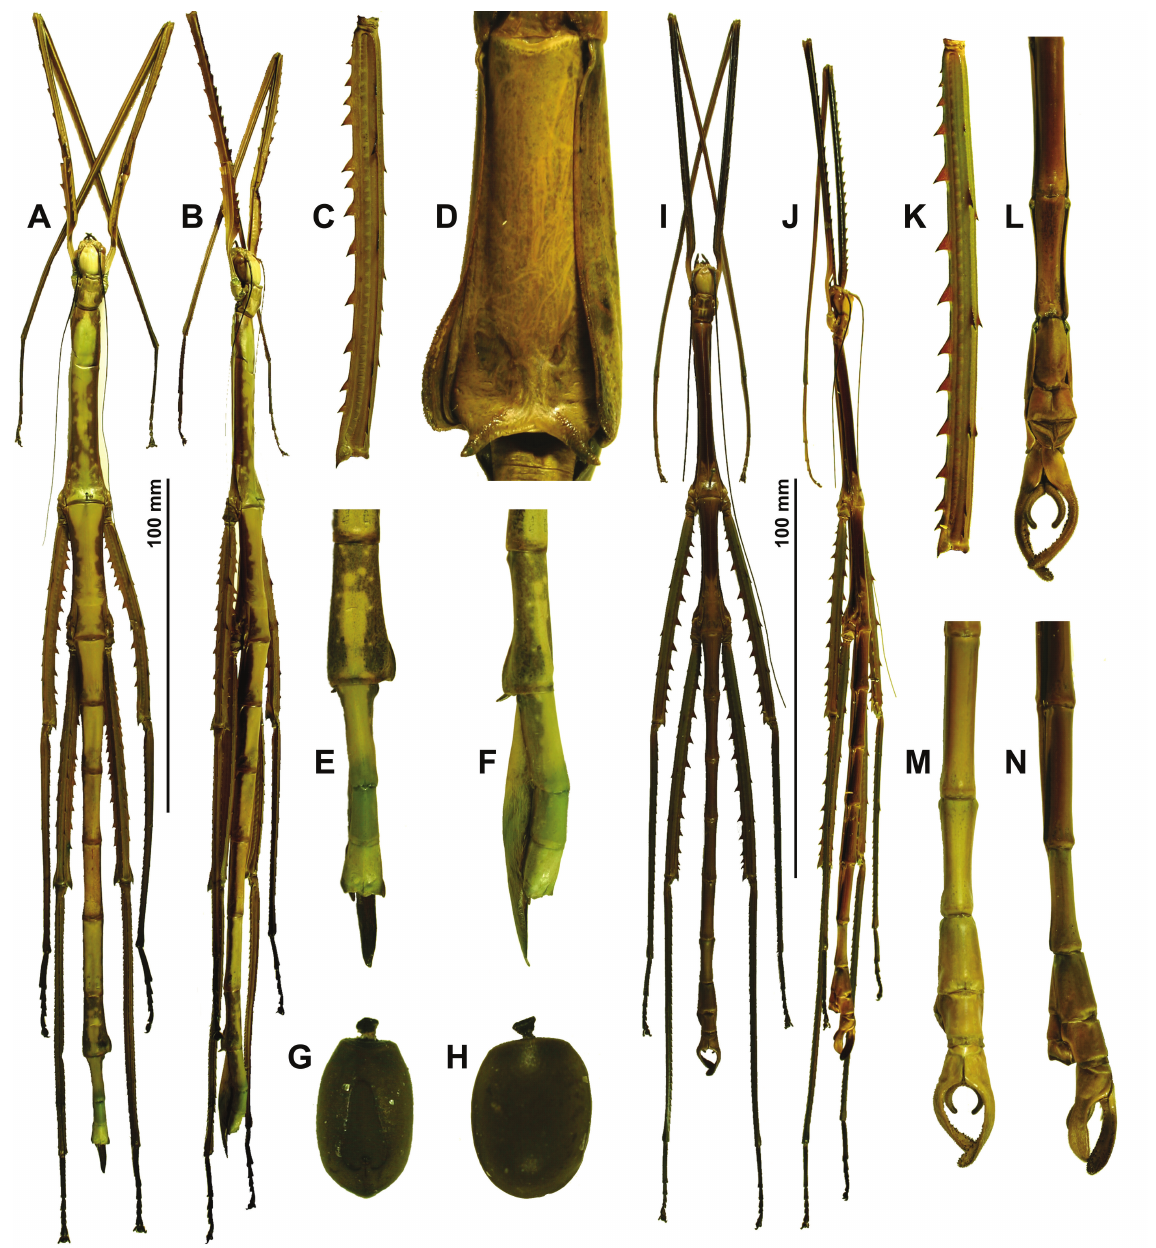
Fig. 3. Phryganistria bachmaensis (Ta & Hoang, 2004) comb. nov. — A–F . ♀. A . Habitus, dorsal view. B . Habitus, lateral view. C . Mesofemur, lateral view. D . Sternum VII and praeopercular organ. E . Apex of abdomen, dorsal view. F . Apex of abdomen, lateral view. — G–H . Egg. G . Dorsal view. H . Lateral view. — I–N . ♂. I . Habitus, dorsal view. J . Habitus, lateral view. K . Mesofemur, lateral view. L . Apex of abdomen, ventral view. M . Apex of abdomen, dorsal view. N . Apex of abdomen, lateral view. C–H, K–N = not to